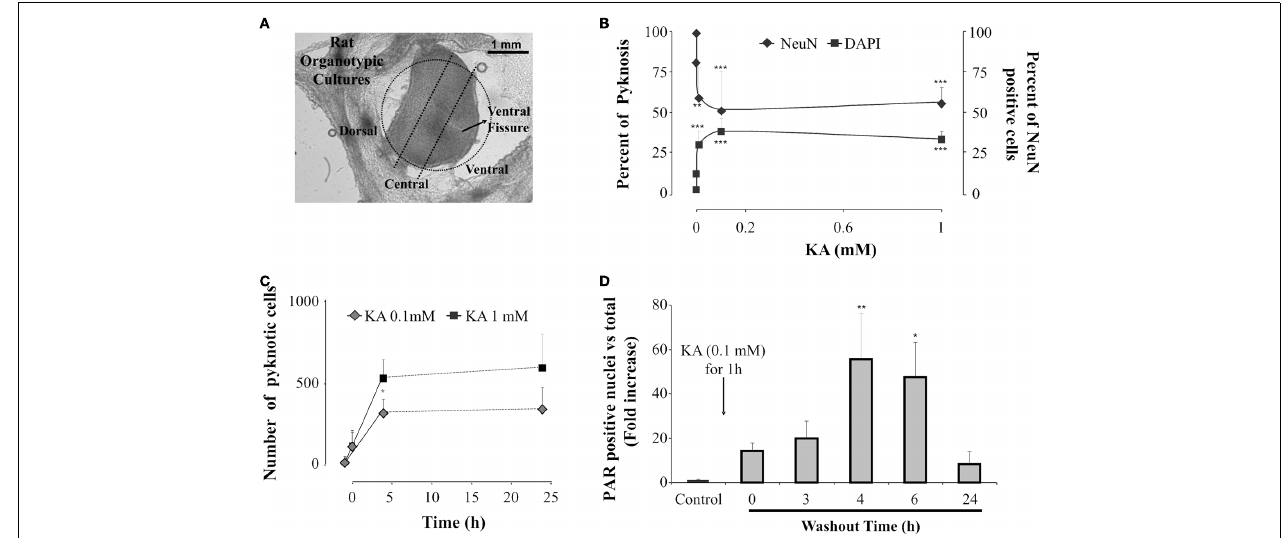
(C) Plot of the number of cells, in the central region, showing pyknosis at various times points after kainate washout (0h) at the concentration of 0.1mM (gray diamonds) or 1mM (filled squares). Data points before 0 time refer to pyknosis in control values (21 ± 23 cells). Note emergence of pyknosis at 4h which is significantly ( P = 0.0005) larger after 1mM kainate. Average data are from three experiments, each one of them run in duplicate. (D) Histograms showing fold increase (with respect to control) in the number of PAR positive nuclei at various times after washing out kainate (0.1mM). The data are from three experiments ( n = 6); * P < 0.05, ** P < 0.01 vs